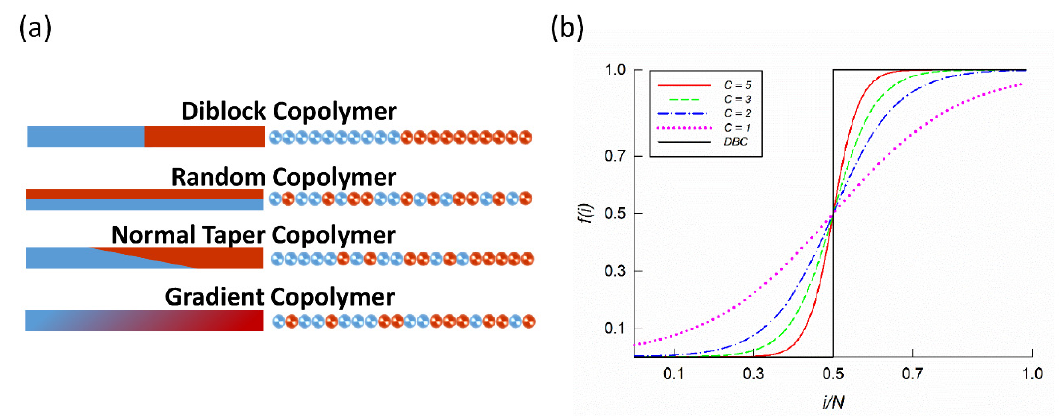
Figure 1. ( a ) Examples of copolymers with different monomer sequences along the chain. The left side shows bars with monomer density profiles and the right side displays possible monomer sequences in the chain. ( b ) Monomer composition profile 𝑓(𝑖) for the 𝐴 segment in a copolymer chain with total length 𝑁 . Figure shows all tan-h composition profiles considered here, with different gradient strengths ( 𝐶 = {1,2,3,5} ) and composition profiles of corresponding diblock copolymers (DBC).